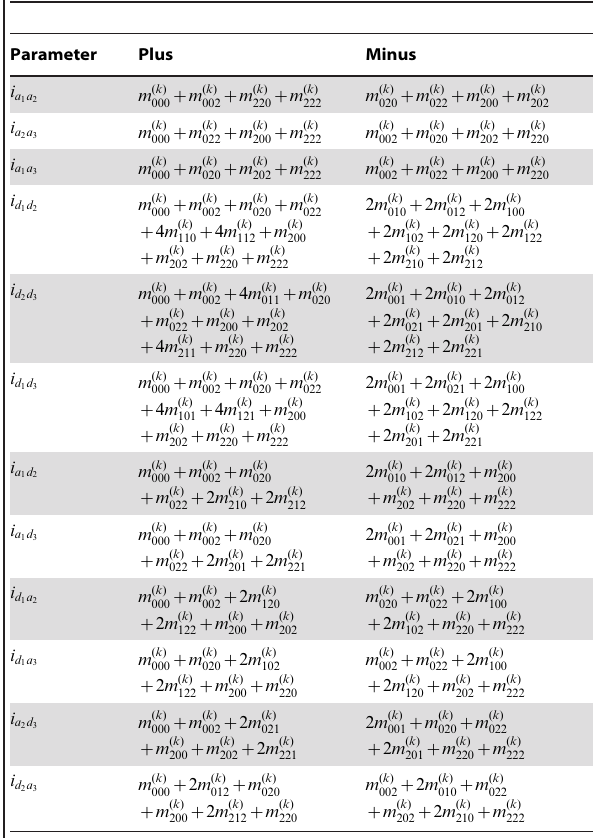
Table 4. The x 2 test statistics for the two-way epistatic effect parameters.